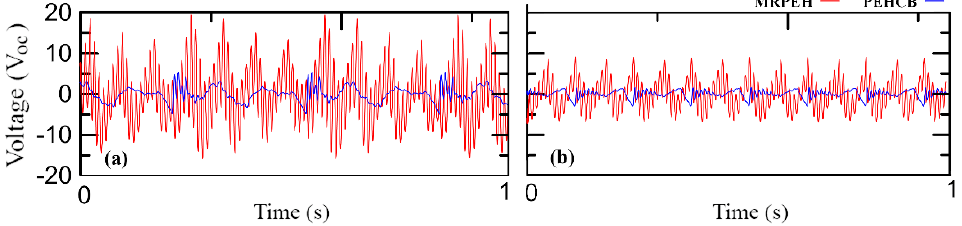
Figure 8. Comparison of open circuit voltage harvested from MRPEH and conventional PEHCB at ( a ) 3.97 Hz and ( b ) 7.66 Hz.